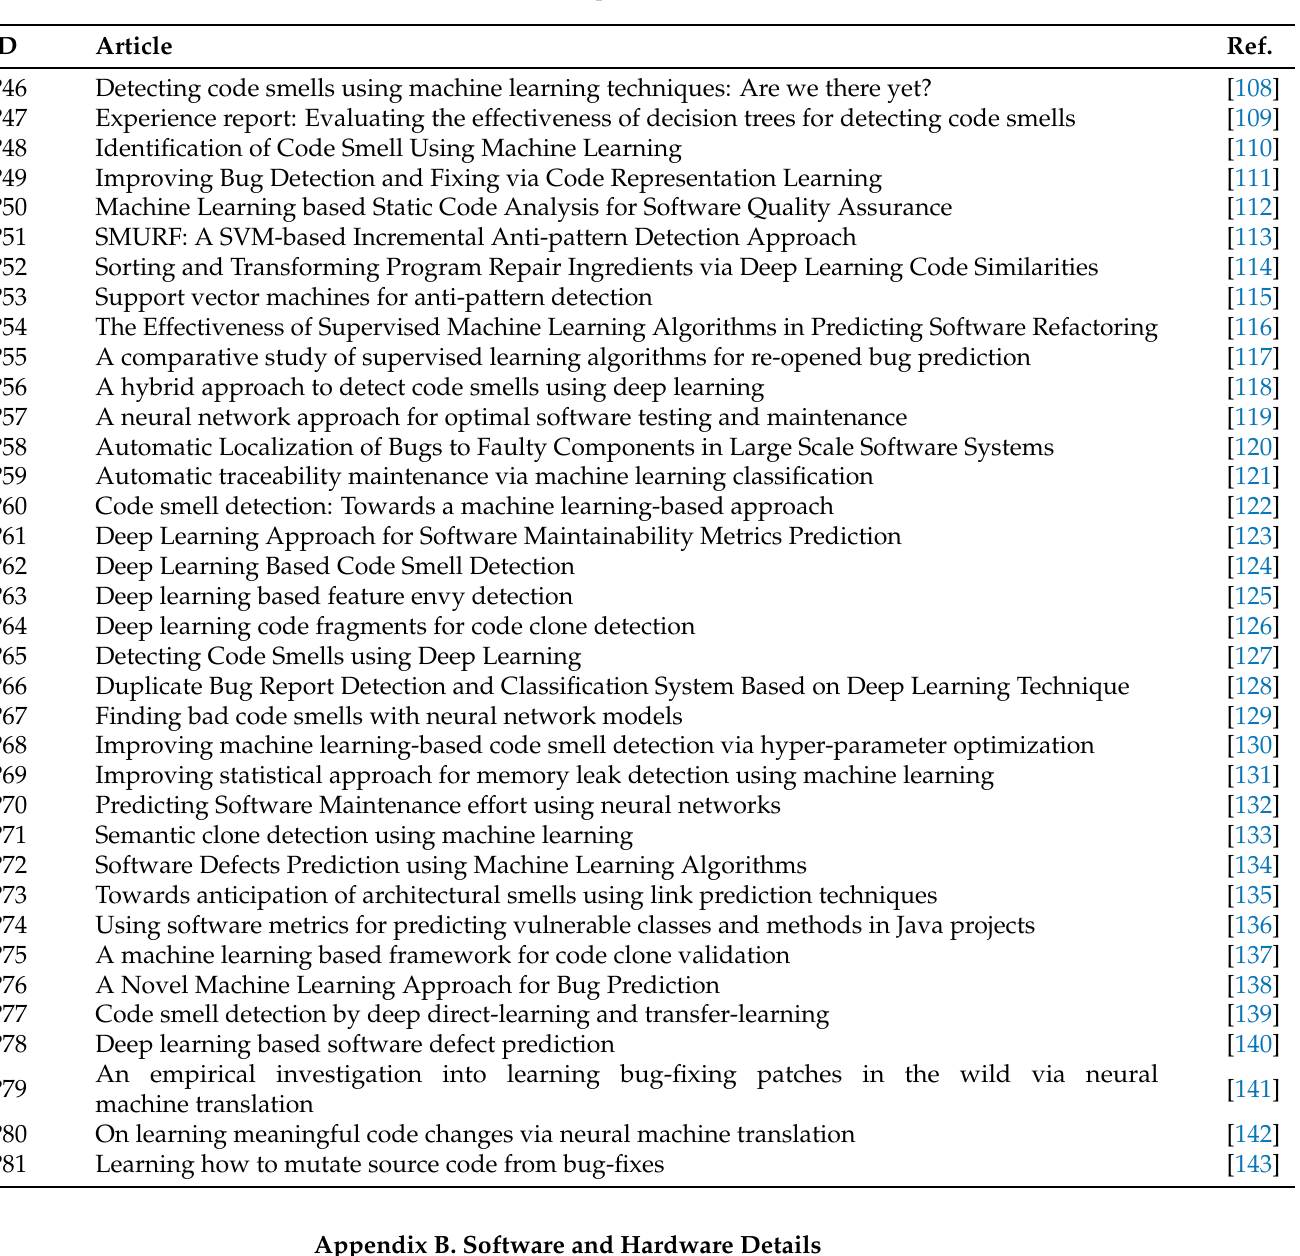
Table A2. Selected articles—part